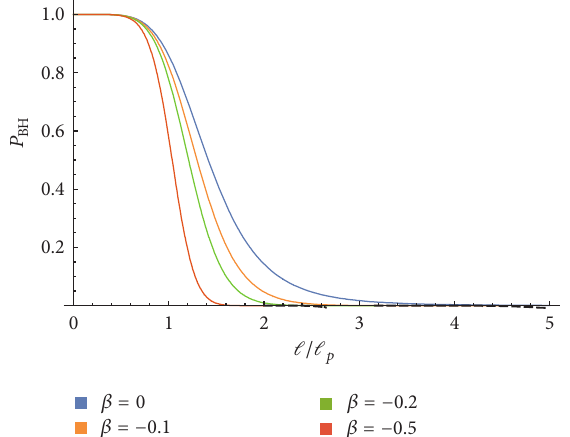
Figure 6: Analytic approximation of the probability 𝑃 BH (𝑚) for a particle to be a black hole versus Gaussian width for decreasing values of the free parameter 𝛽